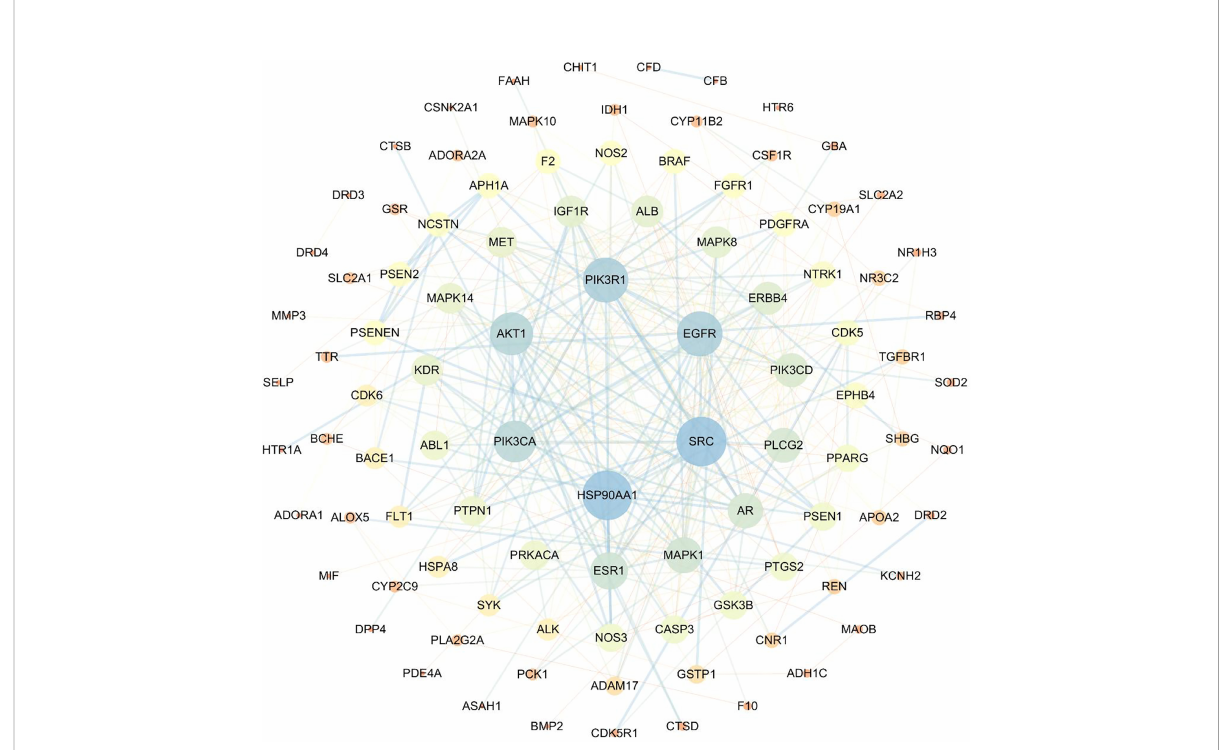
FIGURE 5 Topological network schematic of proteins targeted by 4m and associated with